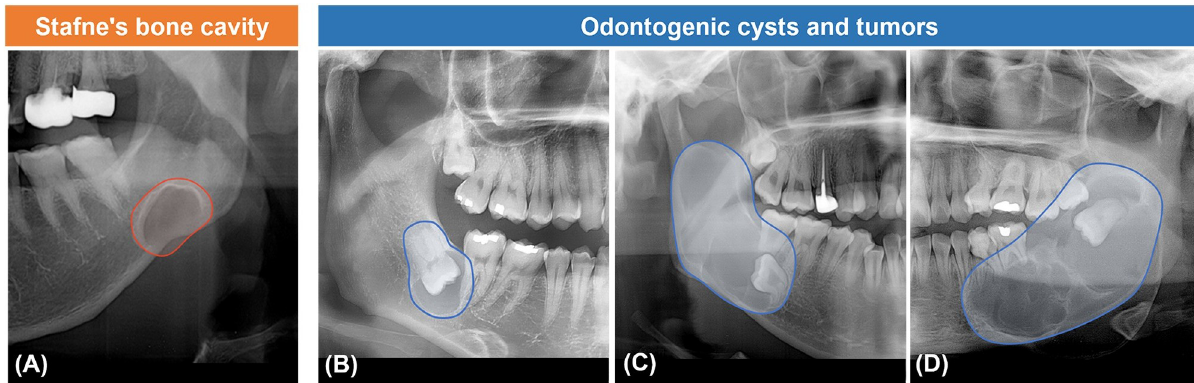
Fig 1. Cropped panoramic radiography of the individual lesion. (A) Stafne’s bone cavity, (B) Dentigerous cyst, (C) Odontogenic keratocyst, (D) Ameloblastoma.